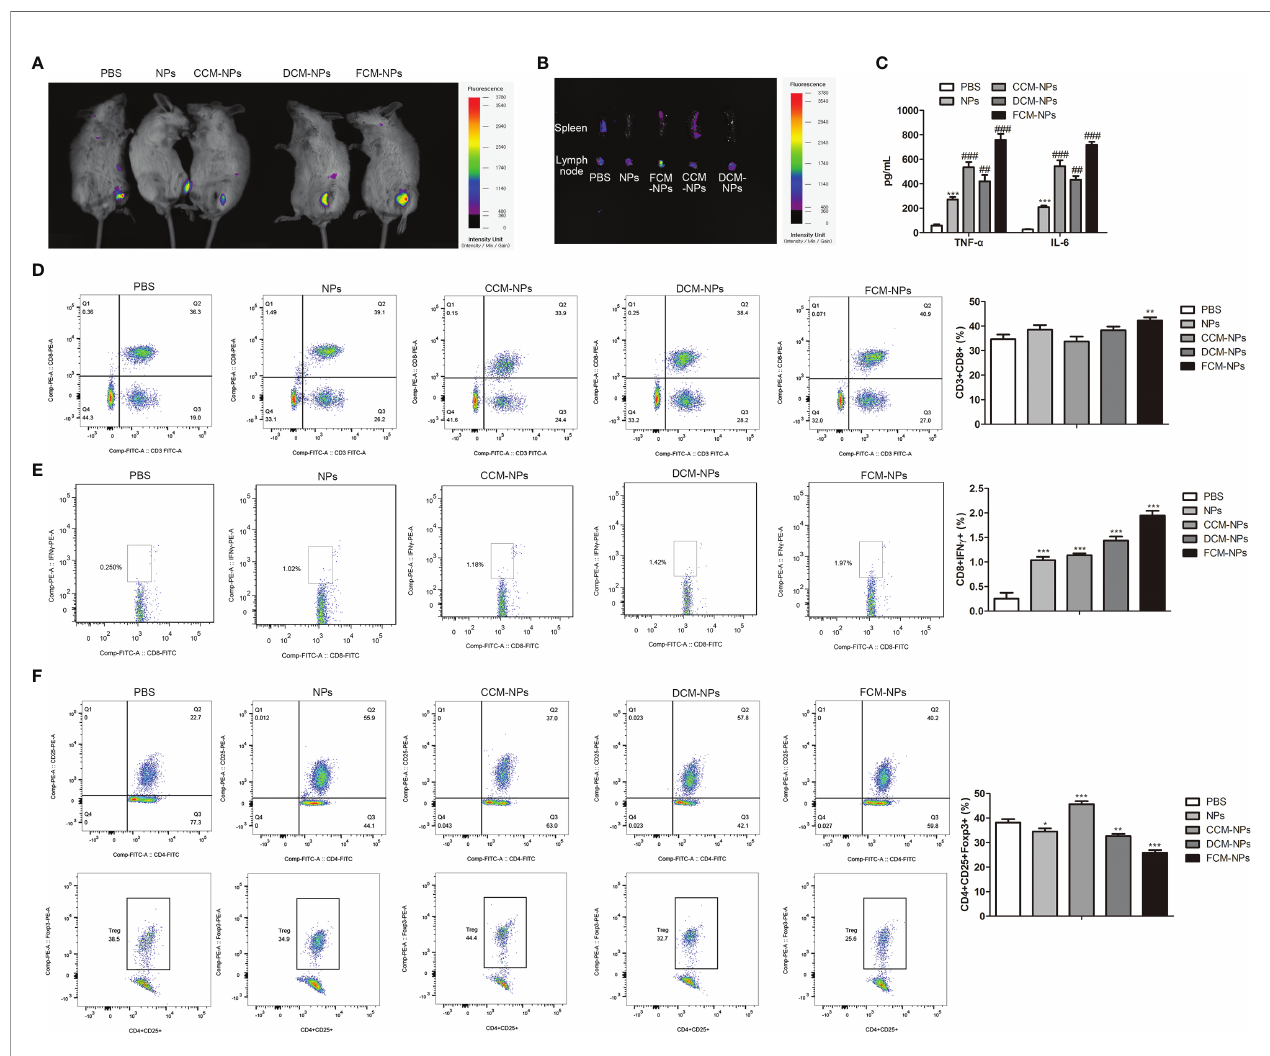
FIGURE 4 | In vivo immune activation of FCM-NPs. (A) In vivo fl uorescence imaging of mice at different time points after vaccine injection. (B) Fluorescence imaging of spleen and lymph node of each group of mice 36 h after vaccine immunization. (C) The secretion of in fl ammatory cytokines TNF- a and IL-6 in serum detected by ELISA. ** P < 0.01, *** P < 0.001 vs PBS group, ## P < 0.01, ### P < 0.001 vs NPs group. (D) Flow cytometry analyses of the expression of CD3 and CD8 in spleen of mice treated with PBS, NPs, CCM-NPs, DCM-NPs and FCM-NPs. (E) Flow cytometry analyses of IFN- g + and CD8 + effector T cell in each group. (F) Flow cytometry analyses of the CD4 + CD25 + Foxp3 + Treg cells. * P < 0.05, ** P < 0.01, *** P < 0.001 vs PBS